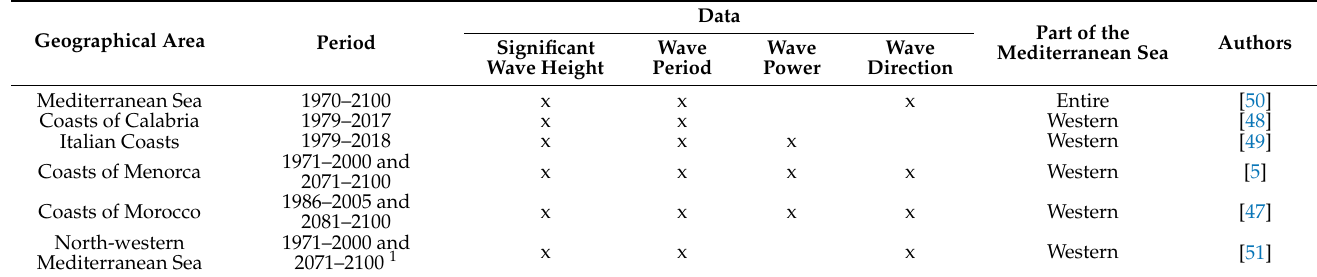
Table 3. Research on ongoing trends of the wave climate in the Mediterranean Sea. Geographical Area